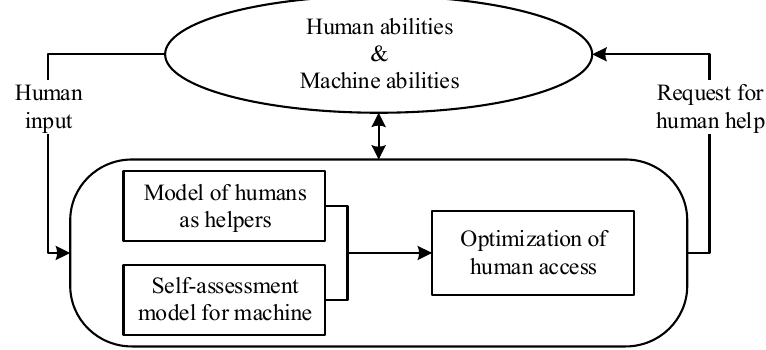
Figure 4. Reasoning capabilities for human-guided machine learning systems.